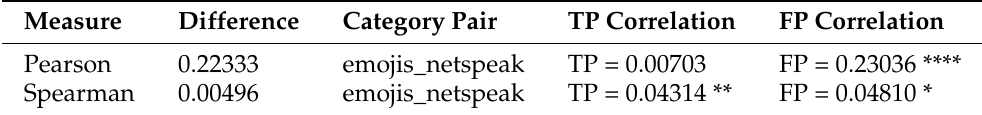
Table 9. Emojis and Netspeak in Suicidal.